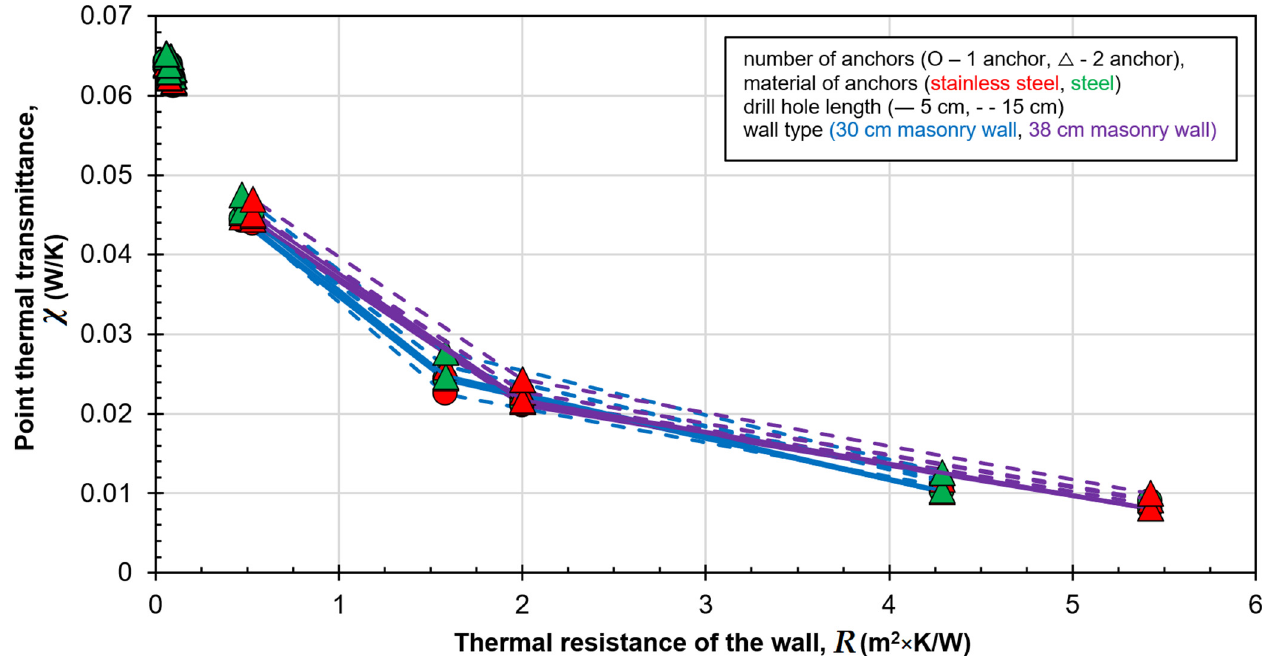
Figure 7. The effect of wall thickness and type and anchors. 20 cm, λ = 0,04 W/(m×K) thermal insulation penetrated with small (0.06 m × 0.06 m × 0.004 m) aluminium brackets equipped with 5 mm PA thermal breaks.